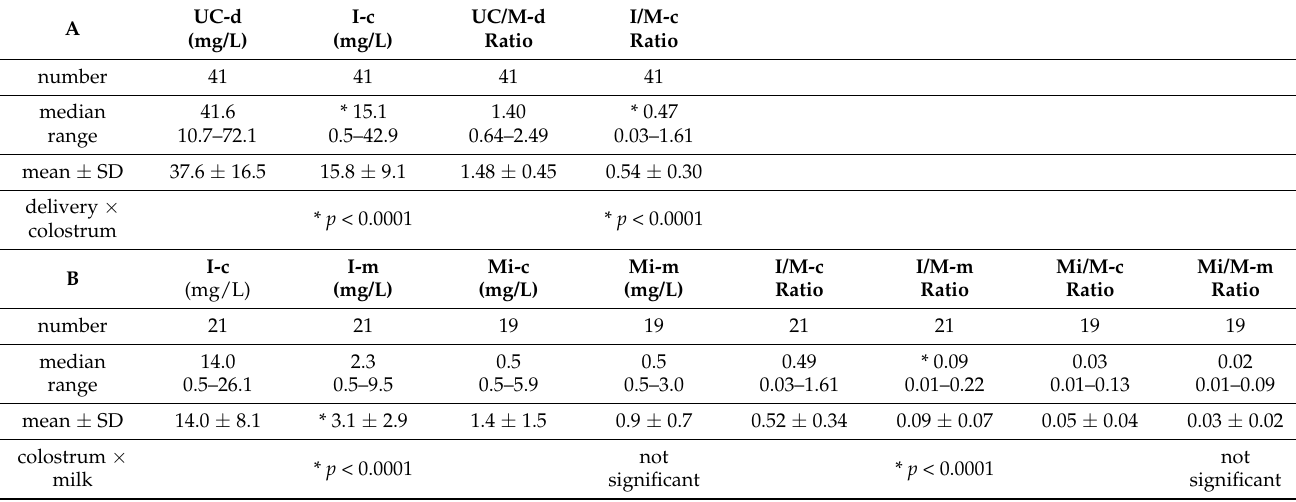
Table 3. Comparison of paired concentrations and ratios of valproic